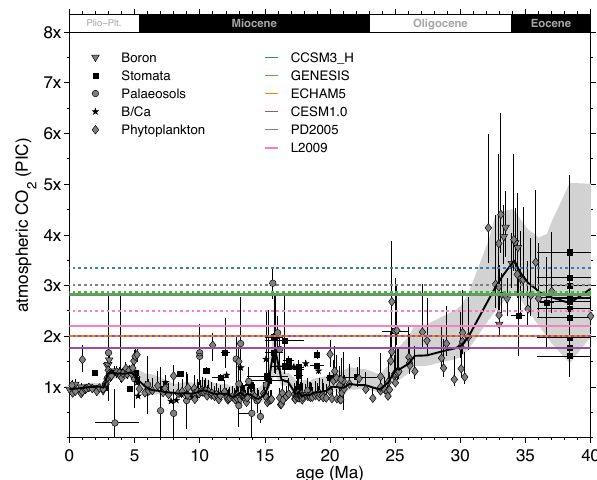
Fig. 11. Proxy estimates of atmospheric CO 2 , reproduced from Beerling and Royer (2011), with Antarctic glacial thresholds from GCM-ISM inter-comparison. The dotted lines are the thresholds for an intermediate ice sheet (25 m Eocene SLE) and the solid lines are the thresholds for a large ice sheet (40 m Eocene SLE), PD2005 is the Pollard and DeConto (2005) simulation with astronomical forcing and L2009 is the Langebroek et al. (2009) simulation with astronomical forcing. Note that this plot excludes simulations from HadCM3L, FAMOUS, GISS_ER and CCSM3_W, which did not form an intermediate-sized ice sheet (see text)